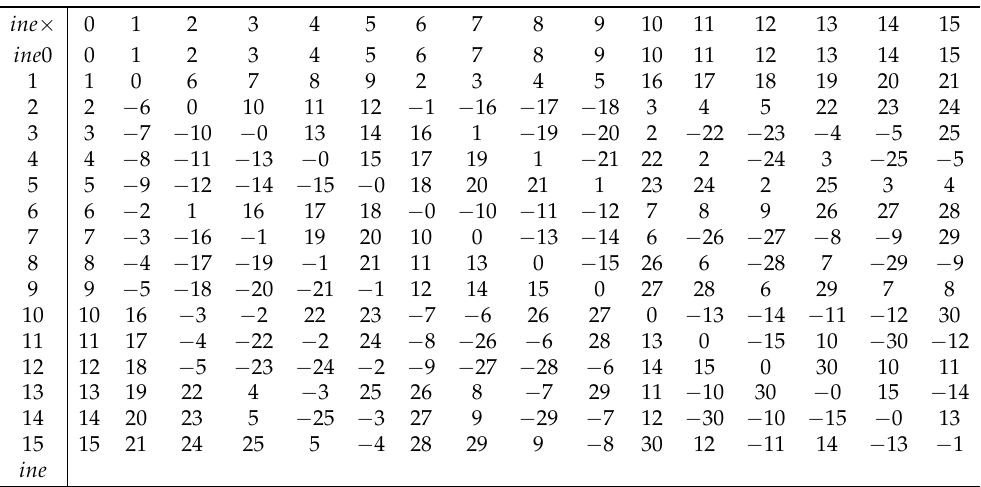
Table 1. Multiplication rules of Kaluza numbers for e 0 , e 1 , . . . , e 15 and e 0 , e 1 , . . . , e 15 (elements e i denoted by their subscripts, i.e., i = e i )